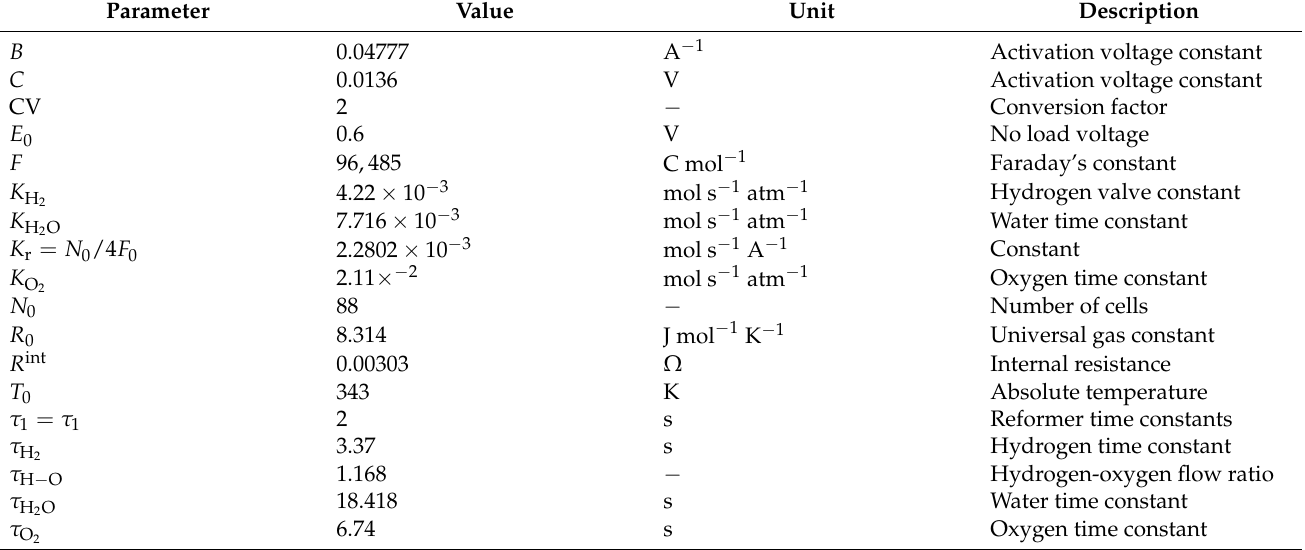
Table 1. Parameters of the fundamental continuous-time model of the PEM system. Value Unit